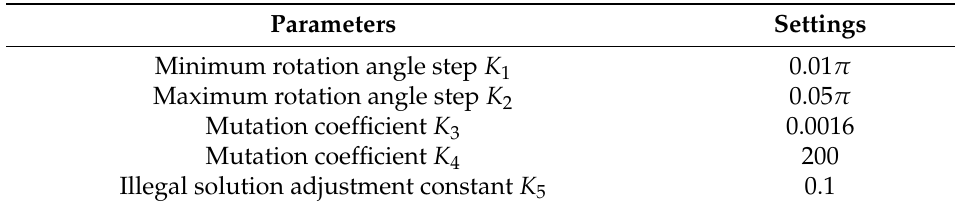
Table 2. Parameter settings for GNF-QGA.